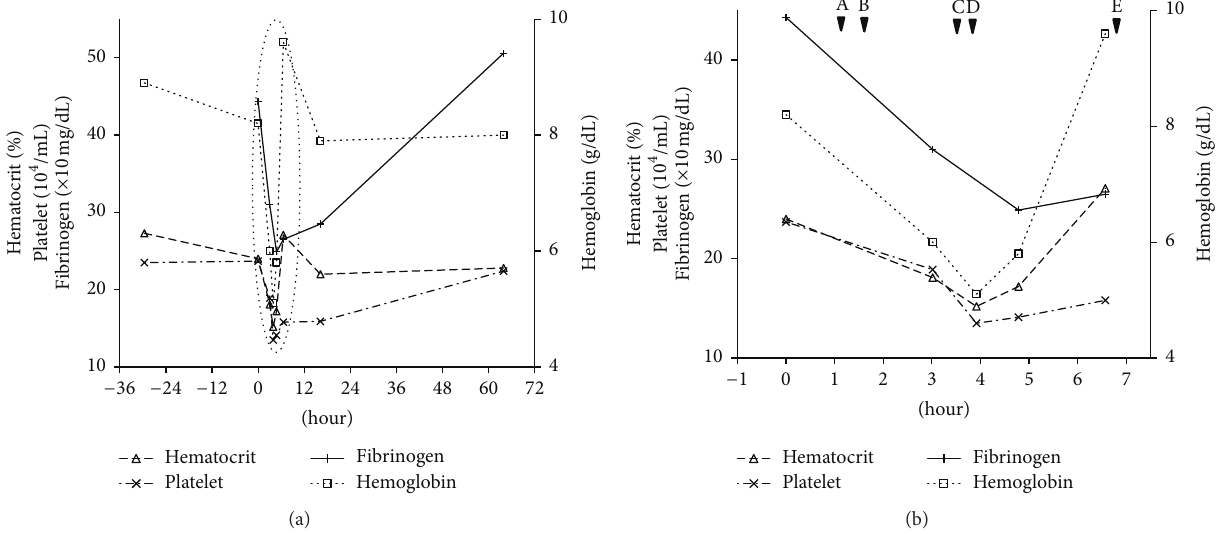
Figure 3: Chronological changes in laboratory data and a review of the procedures during the perioperative period. “0” on the horizontal axis indicates the time of admission. The right vertical axis represents the hemoglobin level, whereas the left vertical axes represent the hematocrit, platelet, and fibrinogen levels. (a) Overall view from the day before admission to the third postoperative day. The dotted circle area indicates the perioperative period. (b) Magnification of the dotted circle area from Panel (a). The upper-case alphabet with an arrow head indicates the time of the procedure. (A) Time of endoscopic hemostasis. (B) Observation of nonreassuring fetal status on cardiotocography. (C) Time of commencing cesarean section. (D)Time of commencing red blood cell transfusion.(E)Time of commencing fresh frozen plasma